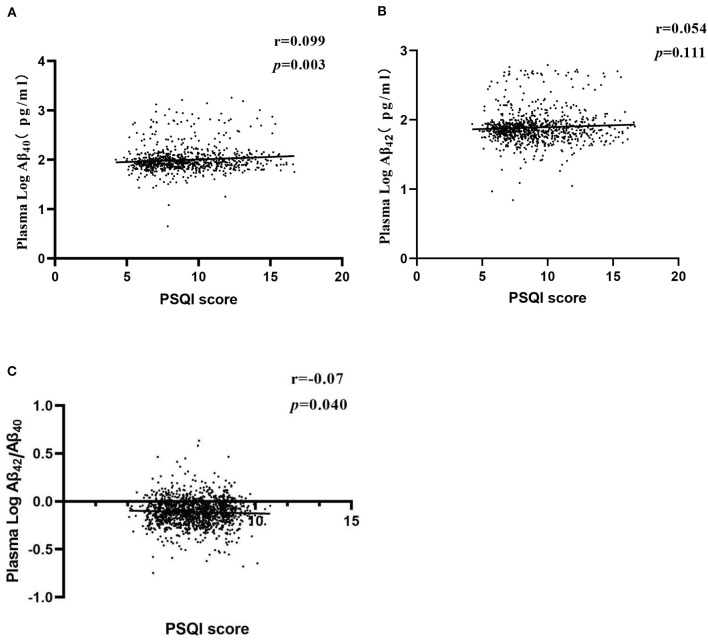
Partial correlations of PSQI score and plasma Aβ levels. Partial linear correlations between PSQI score and log-transformed Aβ40 level (A), log-transformed Aβ42 level (B), and log-transformed Aβ42/Aβ40
(C). Adjusted for age, sex, years of education, smoking, drinking, history of hypertension, history of heart disease, cerebrovascular disease, BMI, FBG, TC, TG, HDL-c, and LDL-c. BMI, body mass index; FBG, fast blood glucose Aβ, amyloid beta; TC, total cholesterol; TG, HDL-c, triglyceride; HDL-c, high-density lipoprotein; LDL-c, low-density lipoprotein.